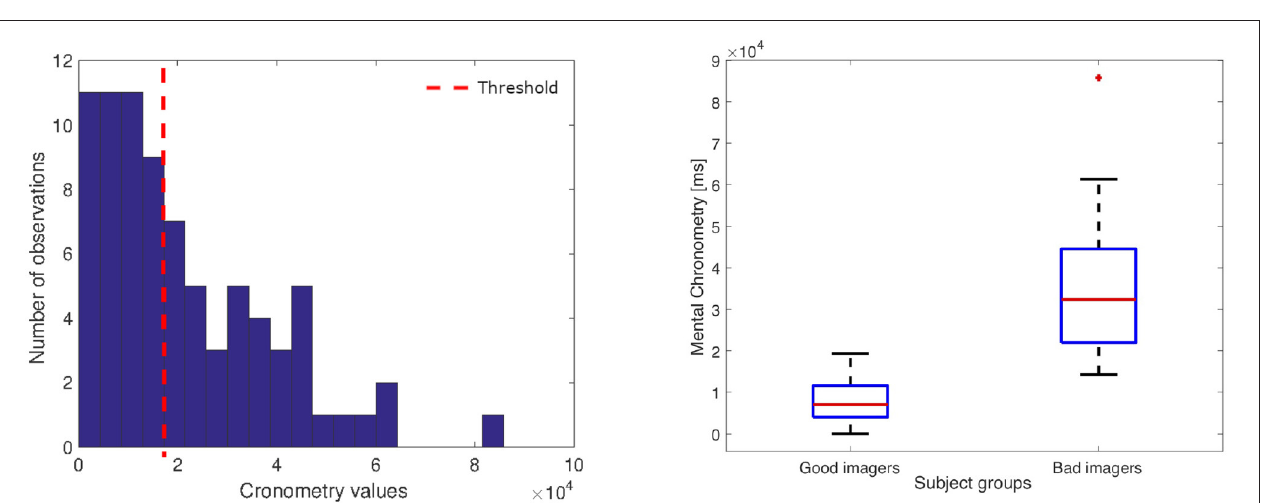
FIGURE 7 | (Left) Histogram of the chronometry values; the dotted line indicates the threshold that split the good from bad imagers. (Right) Box-plot of the Good and Bad imagery MC distributions (GI: median: 7,078 ms, interquartile range (IQR): 7,651 ms; BI median: 32,380 ms, IQR: 22,574 ms).